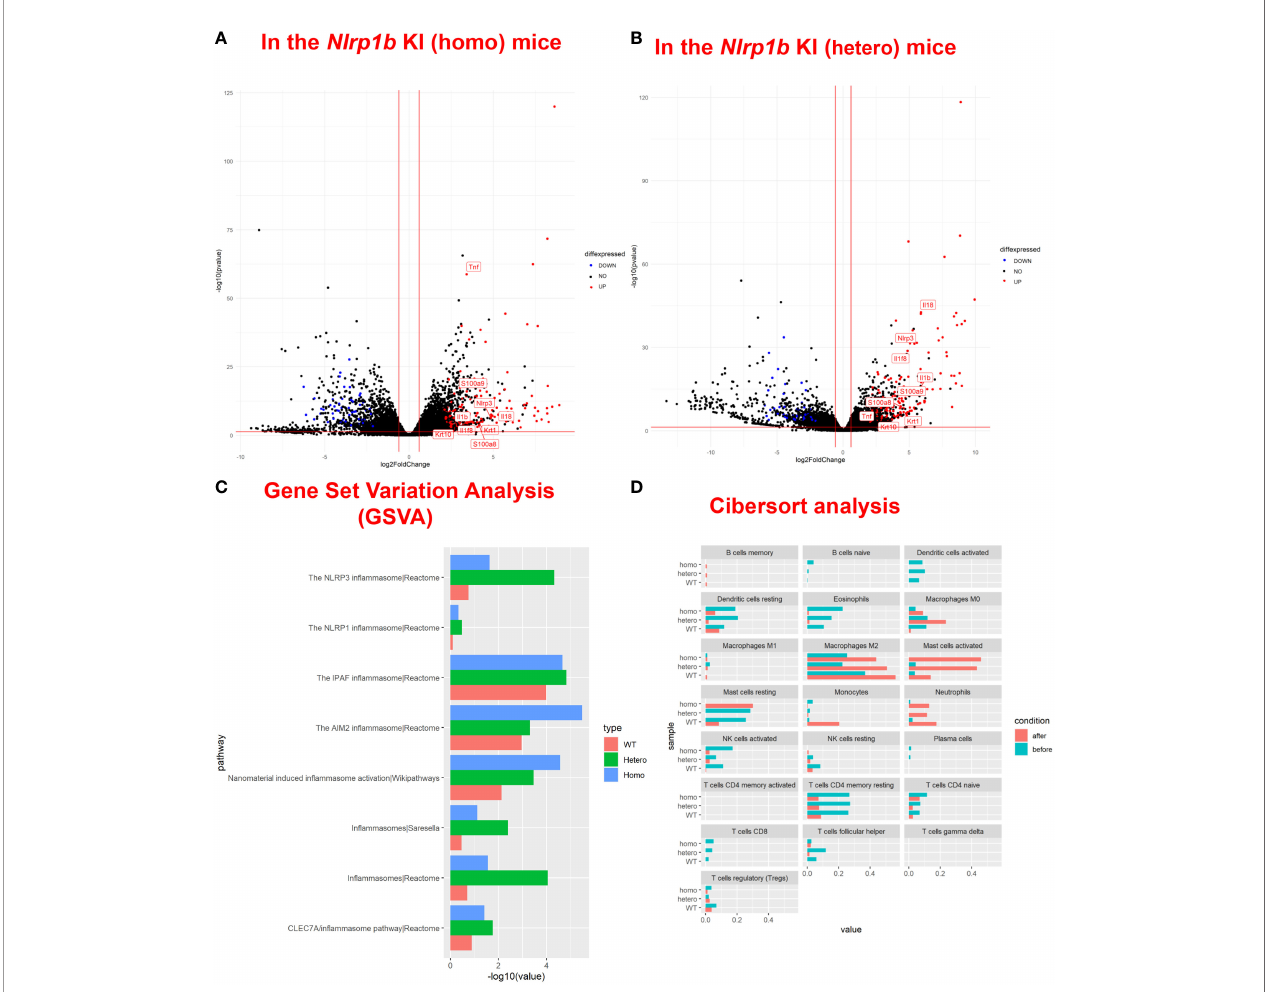
FIGURE 4 | Upregulation of in fl ammasome pathway-related genes, keratinocyte stress marker genes, and keratinocyte differentiation marker genes in Nlrp1b KI mice after UVB irradiation. A volcano plot of upregulated/downregulated genes in the Nlrp1b KI (homo) mice (A) and in the Nlrp1b KI (hetero) mice (B) shows that both IL-1 b and IL-18, which are fi nal products of the NLRP1B in fl ammasome pathway, and keratin 1 (K1) and keratin 10 (K10), which are keratinocyte differentiation marker genes, are signi fi cantly (padj<0.005) and greatly (log 2 -fold change ≧ 2) upregulated after UVB irradiation compared with those before UVB irradiation, compared to the WT mice. (C) Gene set variation analysis (GSVA) shows that UVB irradiation upregulated the expression of genes related to in fl ammasomes, including NLRP1, NLRP3, AIM2 and IPAF, more intensively in the Nlrp1b KI (homo and hetero) mice than in the WT mice. (D) Cibersort analysis shows that fewer M2 macrophages in fi ltrated into the lesional skin of the Nlrp1b KI (homo and hetero) mice than into the lesional skin of the WT mice after UVB irradiation. The Cibersort analysis also shows that more activated mast cells in fi ltrated into the lesional skin of the Nlrp1b KI (homo and hetero) mice than into the lesional skin of the WT mice after UVB